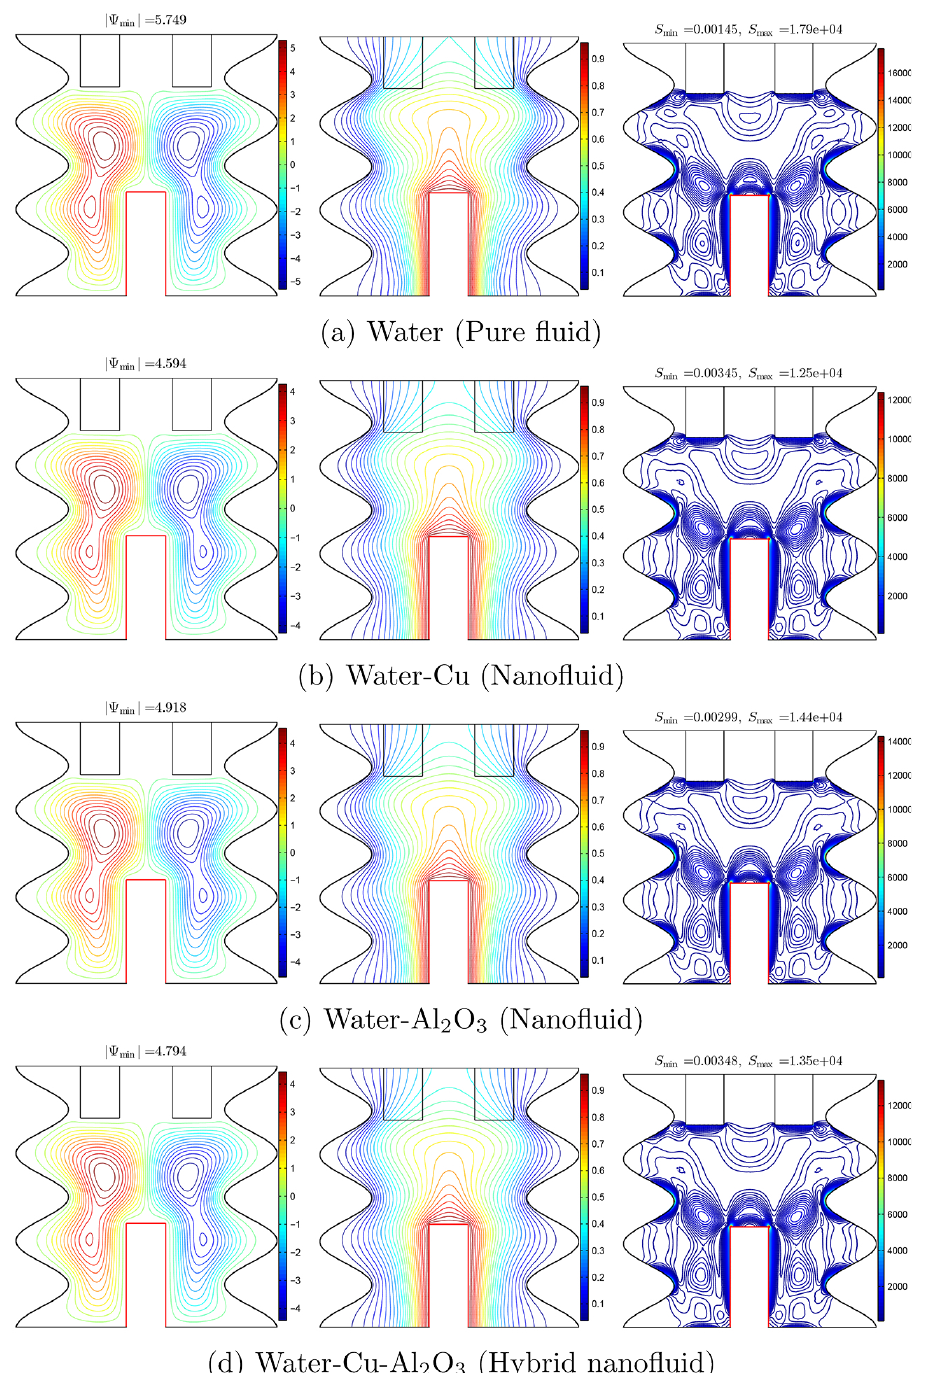
Figure 6. The streamlines ( left ), temperature contours ( middle ), and entropy generation contours ( right ) for various types of particles when Ra = 10 5 , φ = 0.02, and D =